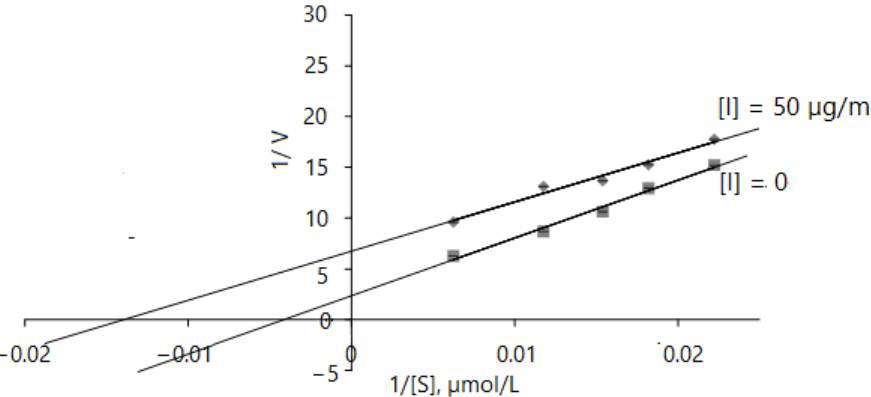
Figure 5. Mathematical modeling of Lineweaver–Burk inhibition plot on enzyme activity using different concentrations of ATChI (0, 45, 55, 65, 85 and 160 µM). The signs and symbols on the graphic refers: squares: none inhibitor, rhombuses: 50 µg/mL of leaves extract concentration; [I]: inhibitor/extract; [S]: substrate. Values represent mean ± standard deviation of triplicate samples.